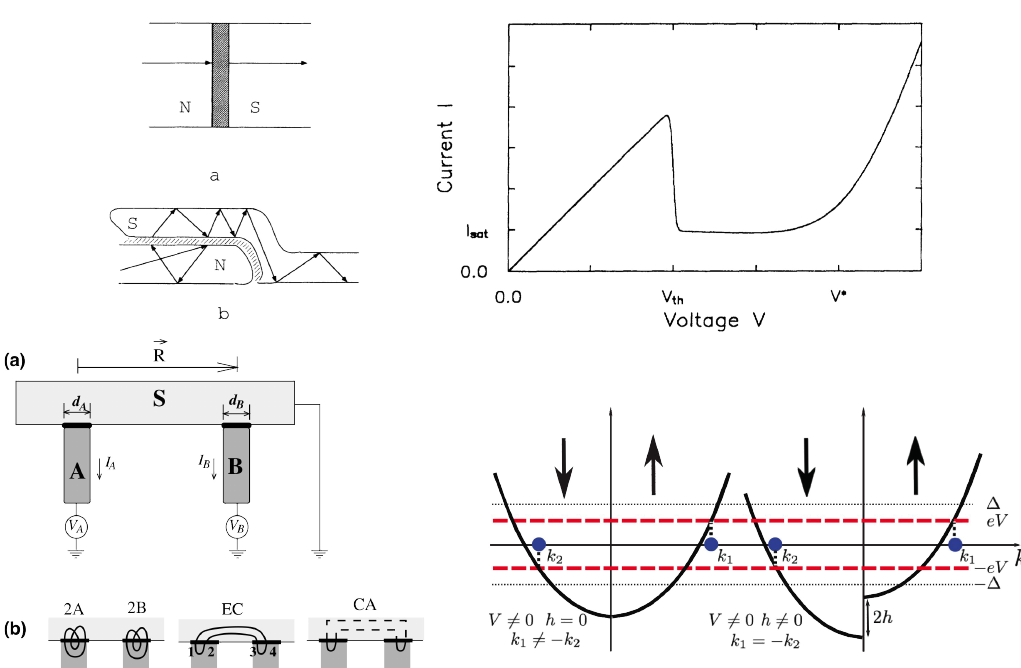
Figure 2: Top left: two realizations of a N-I-S junction, a ballistic junction (top) and an overlap junction where electrons are confined and scatter on the interfaces [ 16 ] . Top right: Overall I-V characteristic for a NSNS system with a small superconduct- ing grain [ 20 ] . Bottom left: (a) Schematics of the three-terminal A / S / B device; (b) diagrammatic representation of the processes leading to subgap conductance: single- contact two-particle tunneling (2A and 2B), elastic cotunneling (EC), which probes the normal Green’s function (full lines) of S and crossed Andreev (CA), which probes the anomalous propagator (dashed line). Bottom right: schematic energy diagram for a non-magnetic (left) and magnetic (right) metal [ 27 ] . The thick solid parabolas are the dispersions of free electrons with spin up and spin down. The k axis corre- sponds to the Fermi level in the